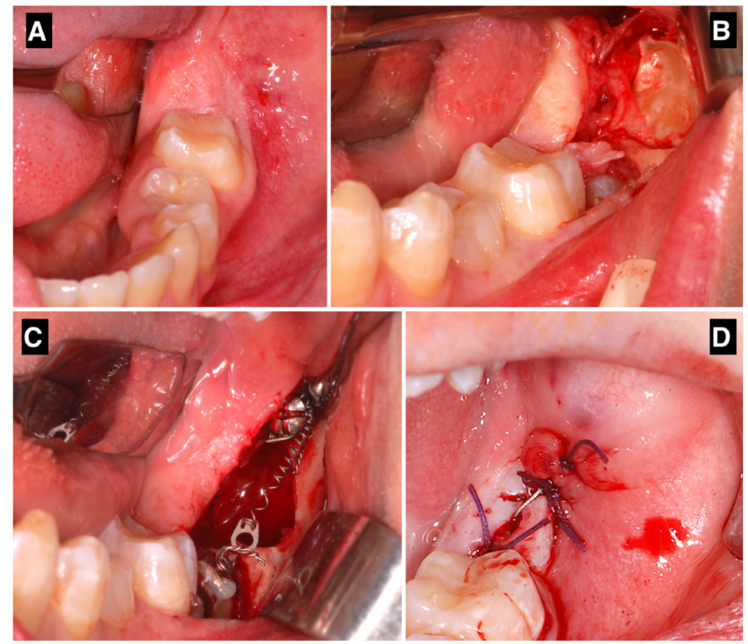
Figure 2. ( A–D ) The surgical procedure, from the initial condition to flap closure.